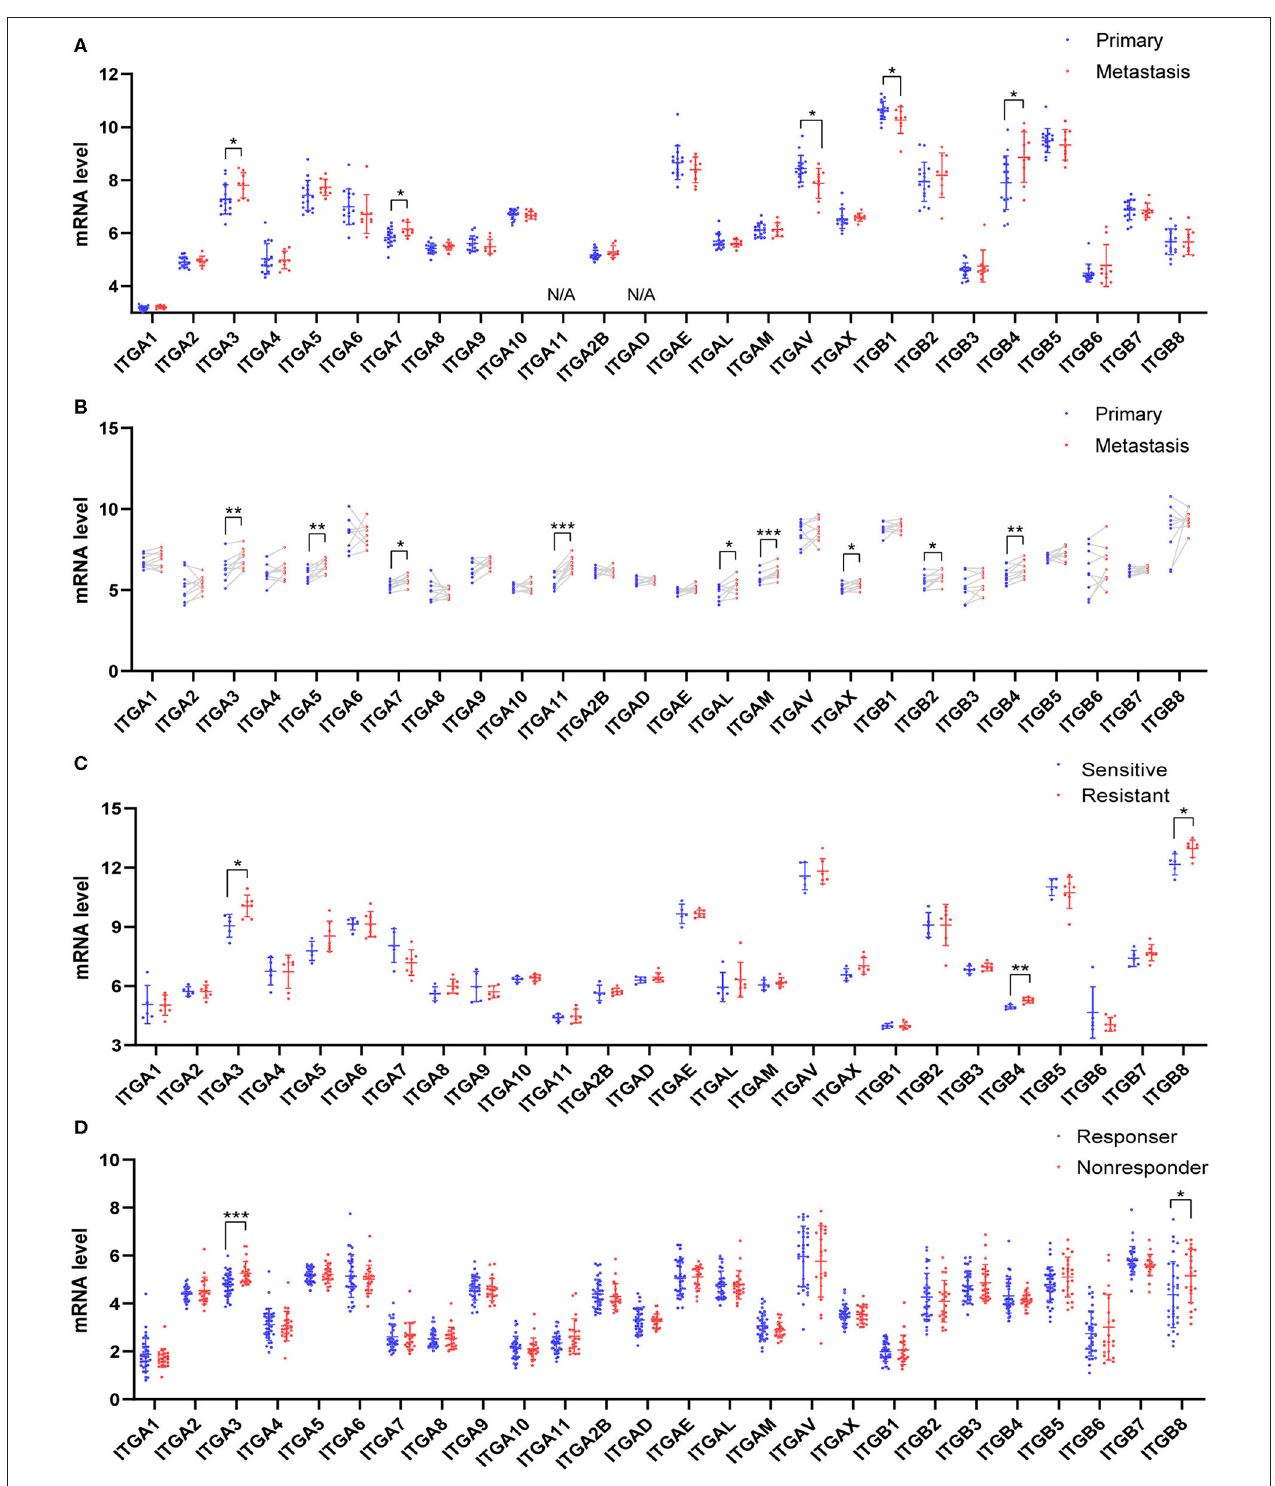
FIGURE 4 | Relationship between integrin genes mRNA expression and metastasis or platinum resistance in OC. (A) Integrin genes transcriptional expression in unpaired primary and metastatic OC tissues, number (primary) = 16, number (metastasis) = 9. (B) Integrin genes transcriptional expression in paired primary and metastatic OC tissues, number (primary) = 9, number (metastasis) = 9. (C) Integrin genes transcriptional expression in platinum-sensitive and platinum-resistant OC tissues, number (sensitive) = 5, number (resistant) = 7. (D) Integrin genes transcriptional expression in platinum-based chemotherapy responder and non-responders OC tissue, number (responder) = 33, number (non-responder) = 22. * p < 0.05, ** p < 0.01, *** p < 0.001.